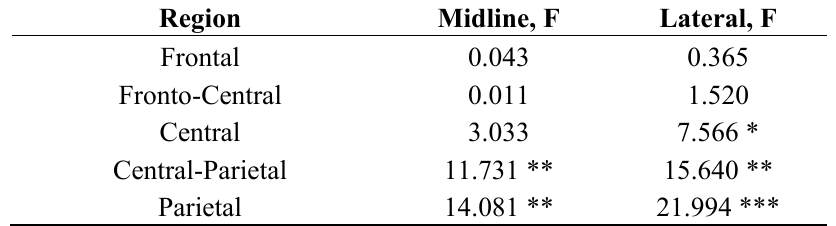
Table 3. Follow-up analysis of the delay × anteriority effect, 600–900 ms from the onset of the pre-delay letter. F -values for the effect of delay are given for each anteriority region.